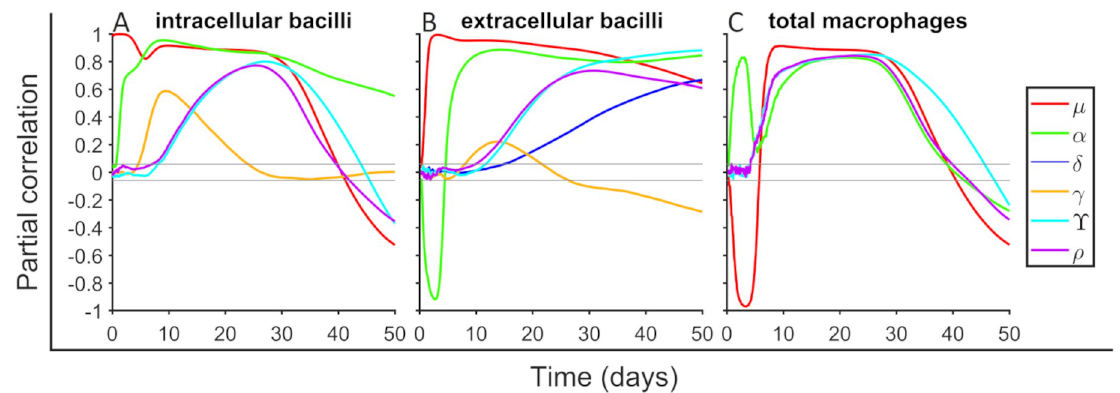
Fig 4. Sensitivity analysis for intracellular bacilli, extracellular bacilli and total macrophages. Partial Rank Correlation Coefficient (PRCC) is computed between a total of six input parameters (see legend) and outcome variables. A total of 1500 parameters sets are used for exploring the parameter space defined in Table 1 using Latin Hypercube Sample technique. A total of 14 parameters are explored, the ones that are not shown it is because their PRCC values is smaller than 0.2. Gray horizontal lines are marked at ± 0.043 to mark significance threshold for PRCC values using a significance level of 0.05. PRCC are computed in each time step (dt = 0.1 day). For each set of parameters a total of 10000 simulations are